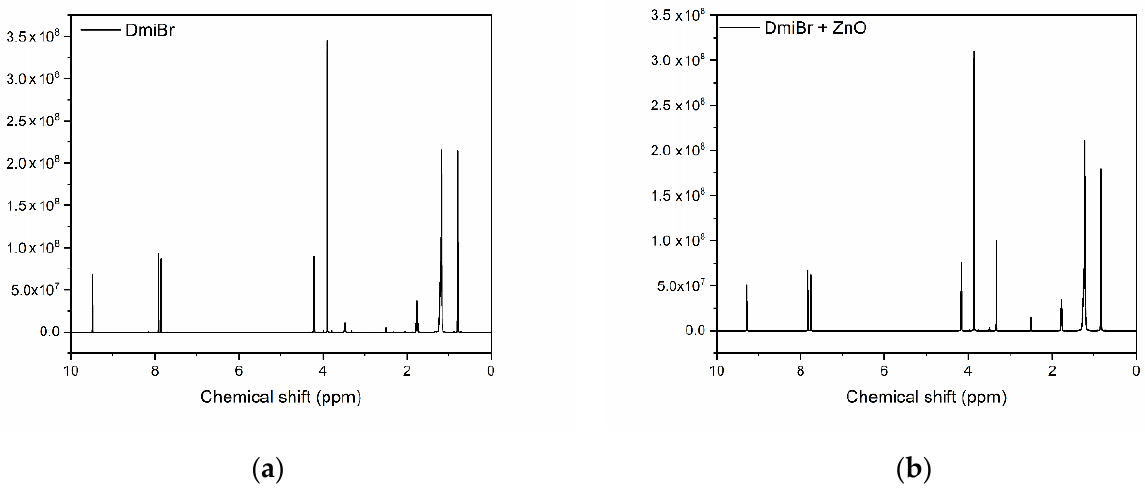
Figure 17. 1 H NMR spectra: ( a ) pure DmiBr; ( b ) 1:1 mixture of DmiBr and ZnO.